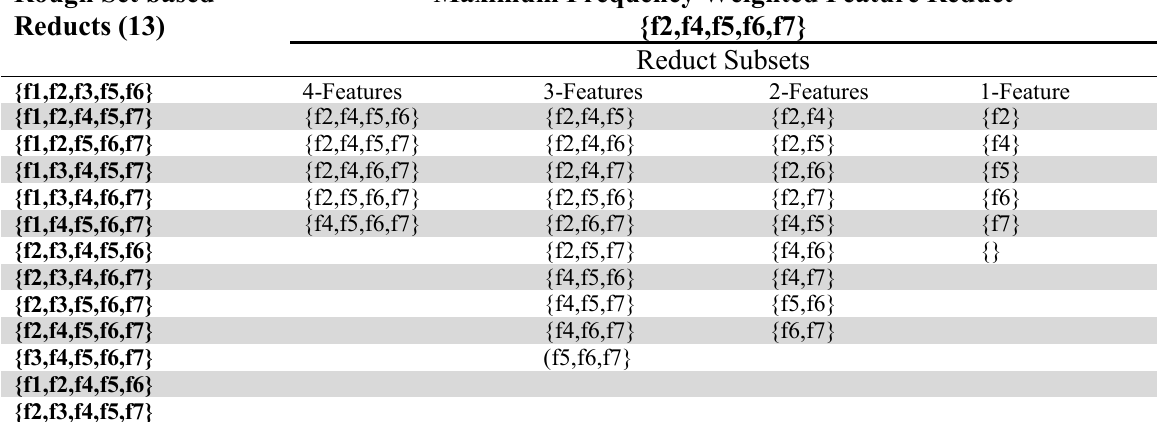
Maximum frequency weighted feature reduct subsets Rough Set based